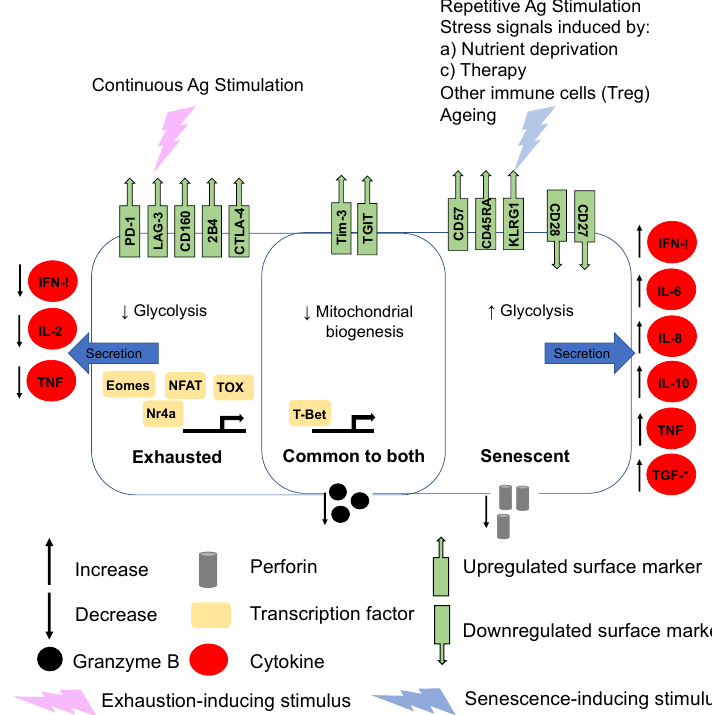
Figure 1. Surface phenotypic, metabolic and transcriptional differences between CD8 + dysfunctional senescent and exhaustive states. Characteristics common to both dysfunctional states are shown the in the middle, purple overlapping section. While both T cell state exhibit decreased effector function, senescent T cells have a very distinct senescence-associated secretory phenotype (SASP) with increased cytokine production of IFN- γ , IL-6, IL-8, IL-10, TNF and TGF- β . In contrast. exhausted T cells are characterized by decreased IL-2, TNF and IFN- γ production. While some surface markers such as Tim-3 and TGIT are common to both dysfunctional T cell states, there is otherwise quite a distinct pattern of expression. Ag = antigen.